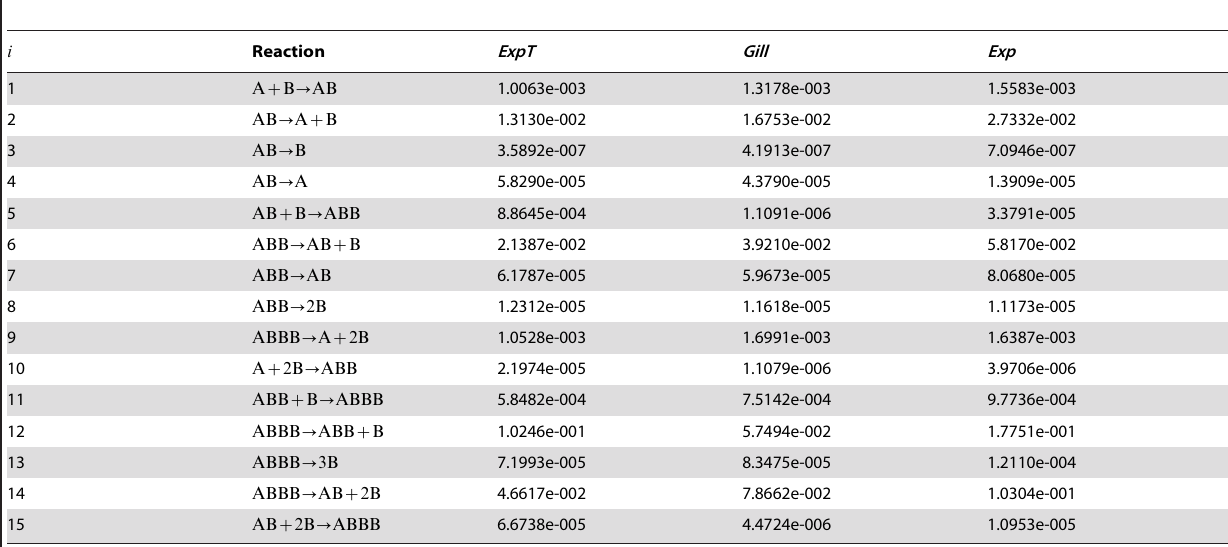
Table 3. Comparison among estimated reaction constants ( k i ), from all sets of data, averages from Gillespie simulations and experimental averages over single experiment.